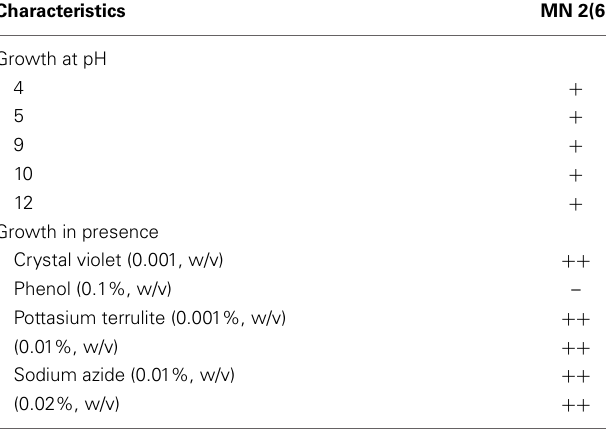
Table 2 | Phenotypic characteristic of MN